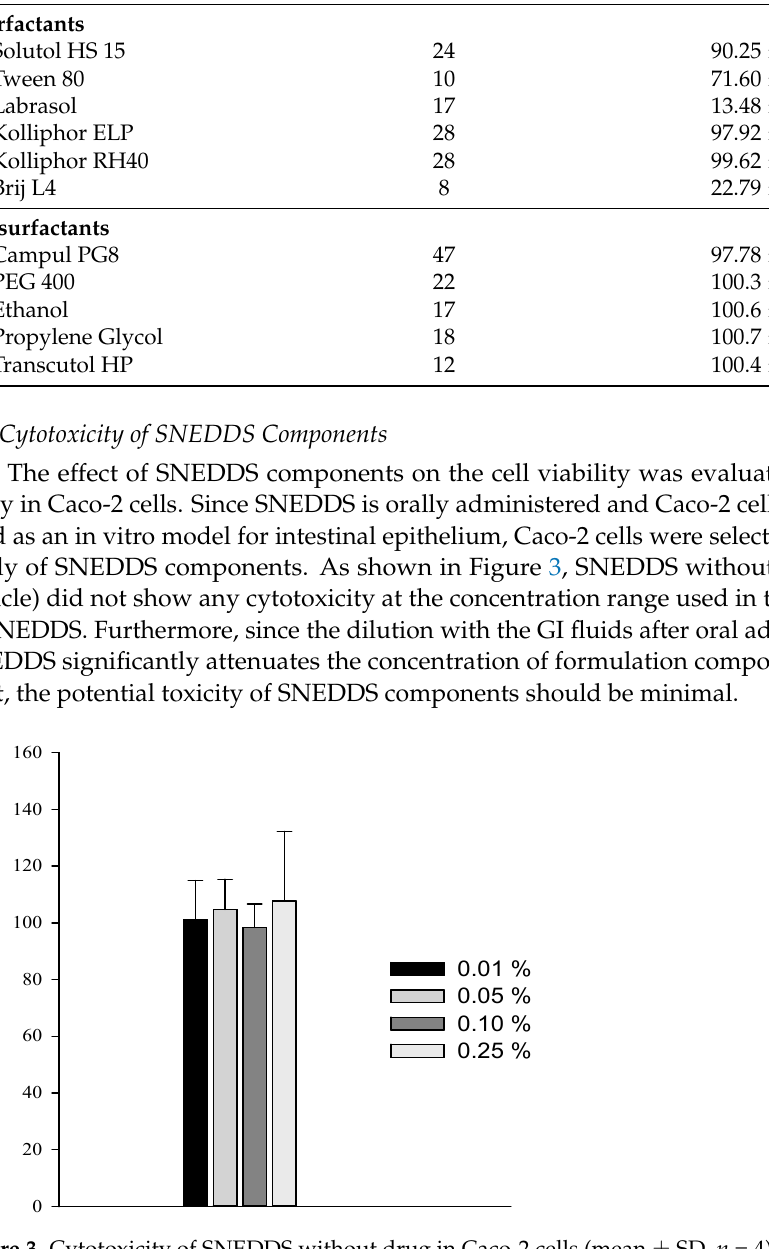
Figure 3. Cytotoxicity of SNEDDS without drug in Caco-2 cells (mean ± SD, n = 4).